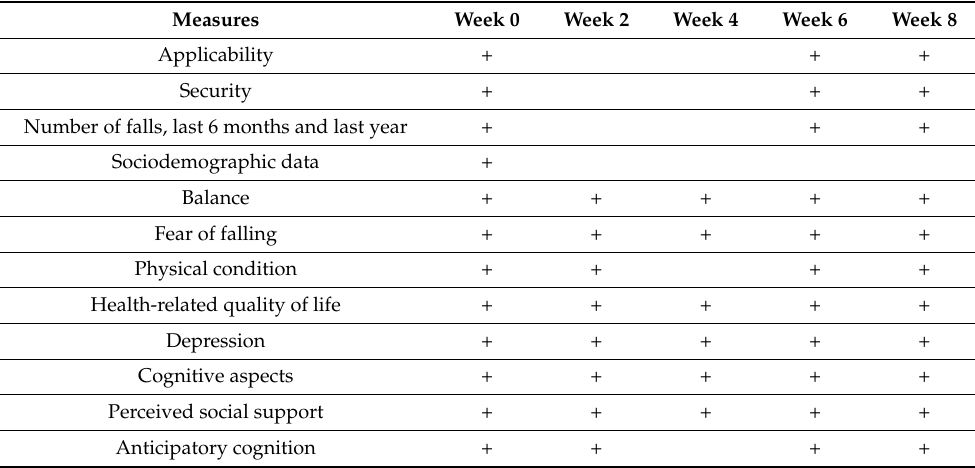
Table 2. Schedule of experimental and control group